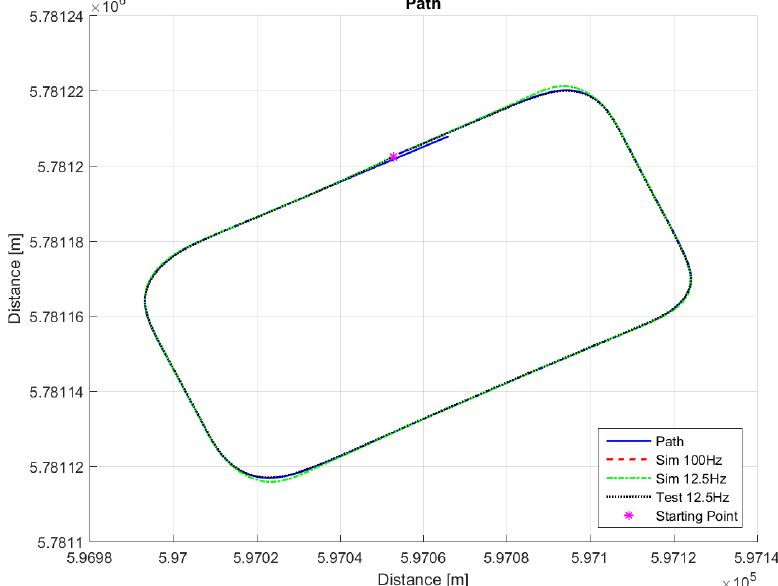
Figure 9. The path, simulation responses and the response from the test